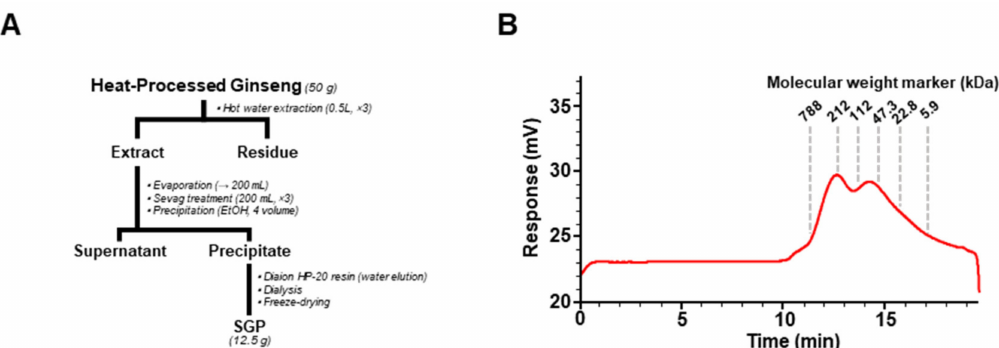
Figure 1. Preparation and molecular weight distribution of heat-processed ginseng polysaccharide fraction (SGP) . ( A ) Ex- traction and fractionation scheme for preparation of SGP. ( B ) HP-GPC chromatogram of SGP. Dotted lines indicate the elution time of each molecular weight marker.